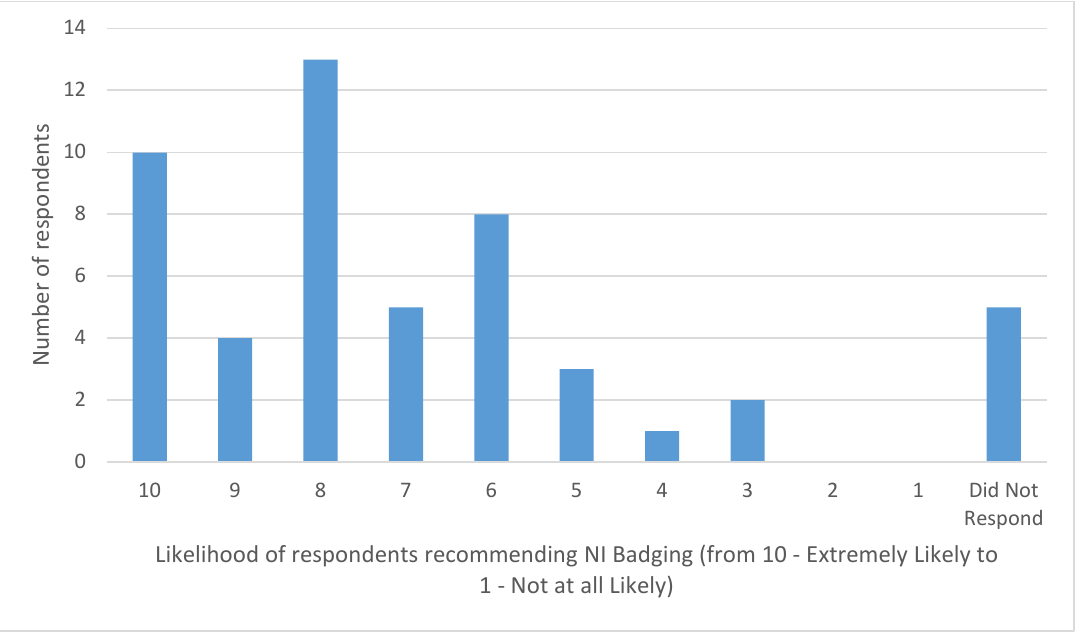
Figure 4. Likelihood of respondents recommending the NI badging pilot program to a